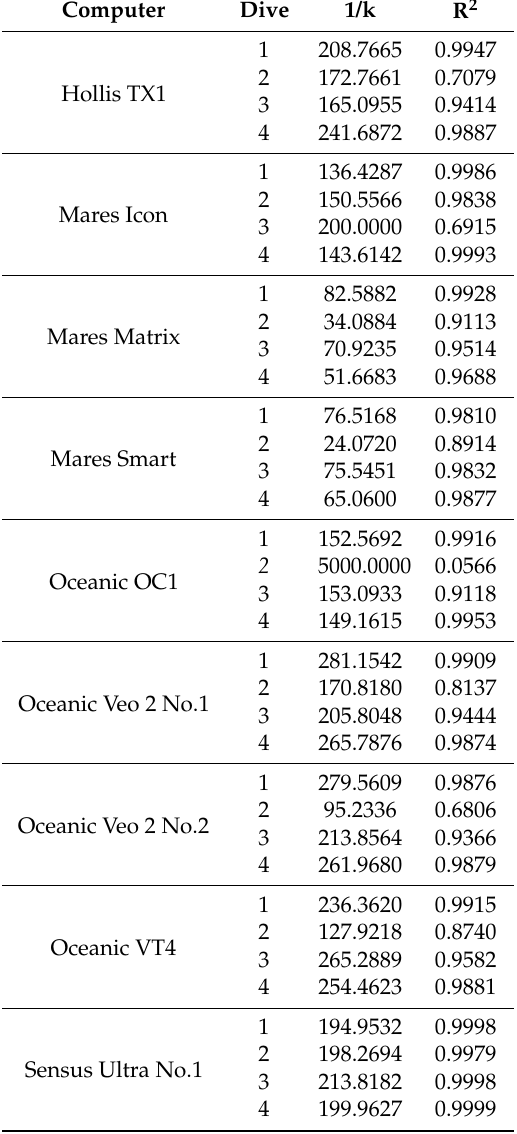
Figure 6. The results of Experiment 2. Table 1. R 2 and time constants for dive computers.